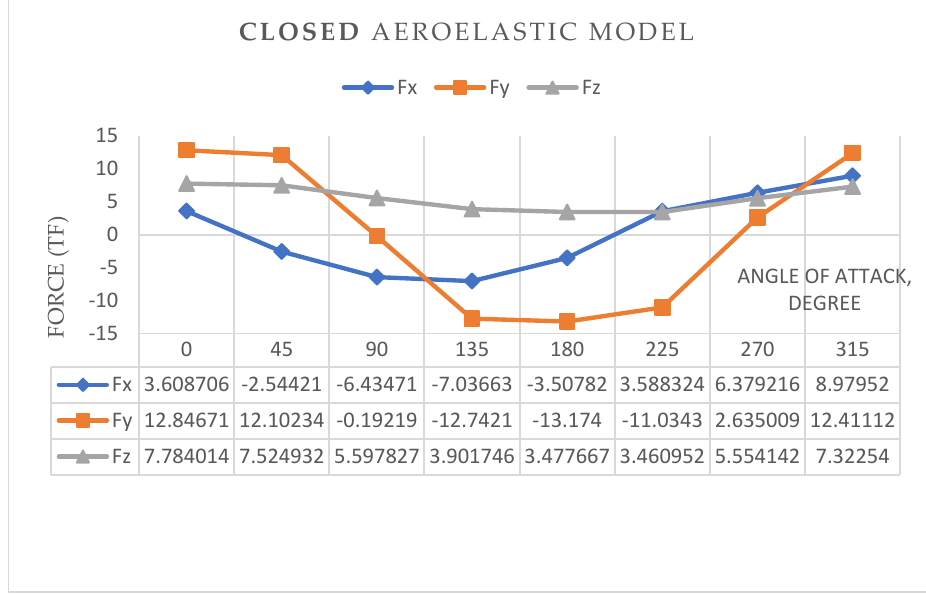
Figure 11. Force curves of Fx, Fy, Fz (tf) when the angle of attack is changed from 0° to 360° for a closed aeroelastic model, Option (1111).